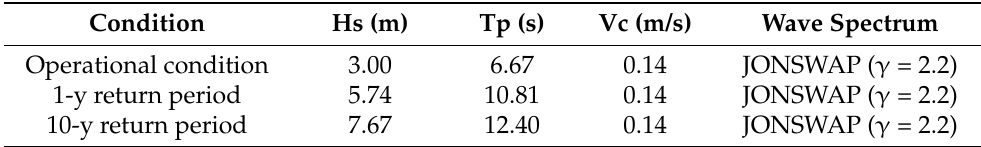
Table 6. Test cases for irregular